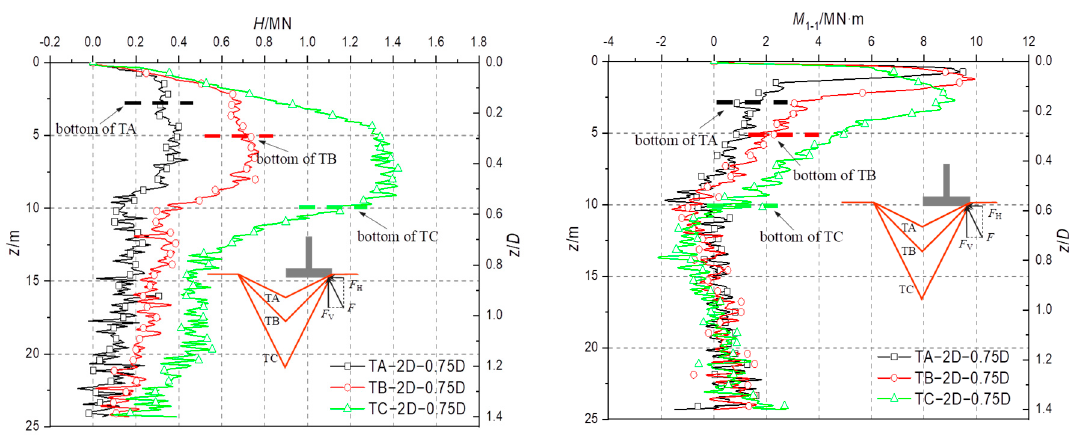
( a ) Effect of footprint geometry on flat base footing ( β = 0.75 D )